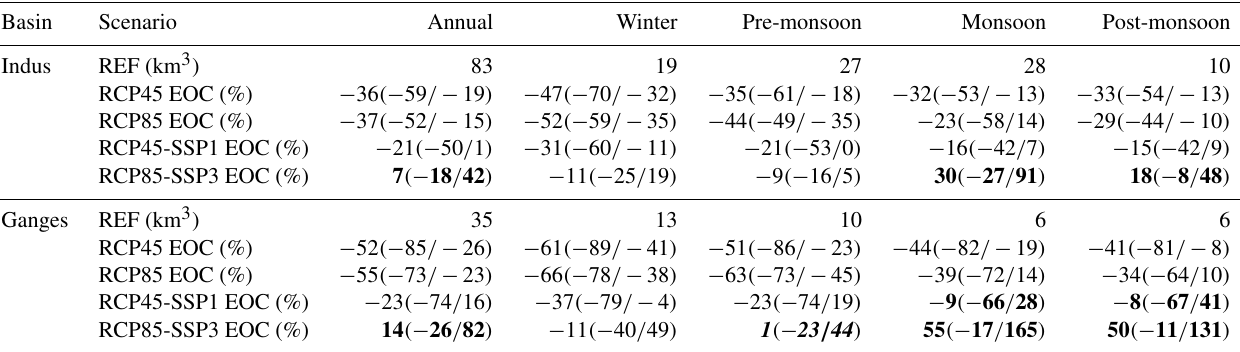
Table 2. Projected changes in the annual and seasonal blue water gap of the Indus and Ganges river basins under present (1981–2010) and far-future (2071–2100; EOC) conditions for RCP4.5, RCP8.5, RCP4.5-SSP1, and RCP8.5-SSP3. The values between the parentheses represent the minimum and maximum projected changes in the blue water gap. The colours indicate the number of model runs (i.e. normal